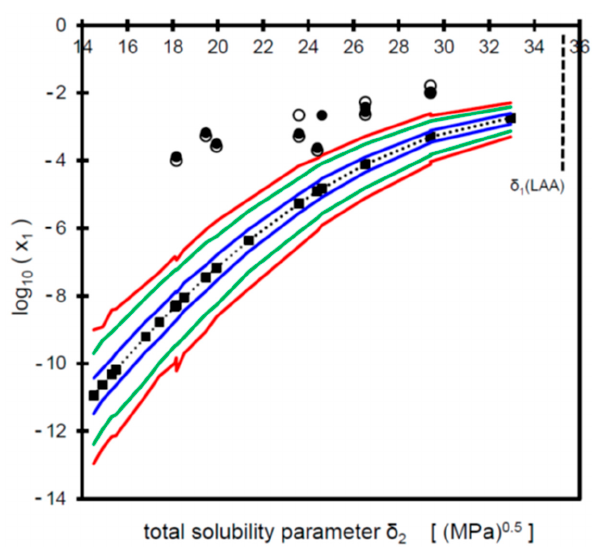
Figure 1. Molar solubility x 1 of L -ascorbic acid at 25 °C from simulation (solid lines) and analytical computations ( ■ ). Experimental data at 20 °C ( ○ ) and 25 °C ( ● ) from references [34–36]. Dashed vertical line indicates the total solubility parameter of L -ascorbic acid δ 1 = 35.3 (MPa) 0.5 .